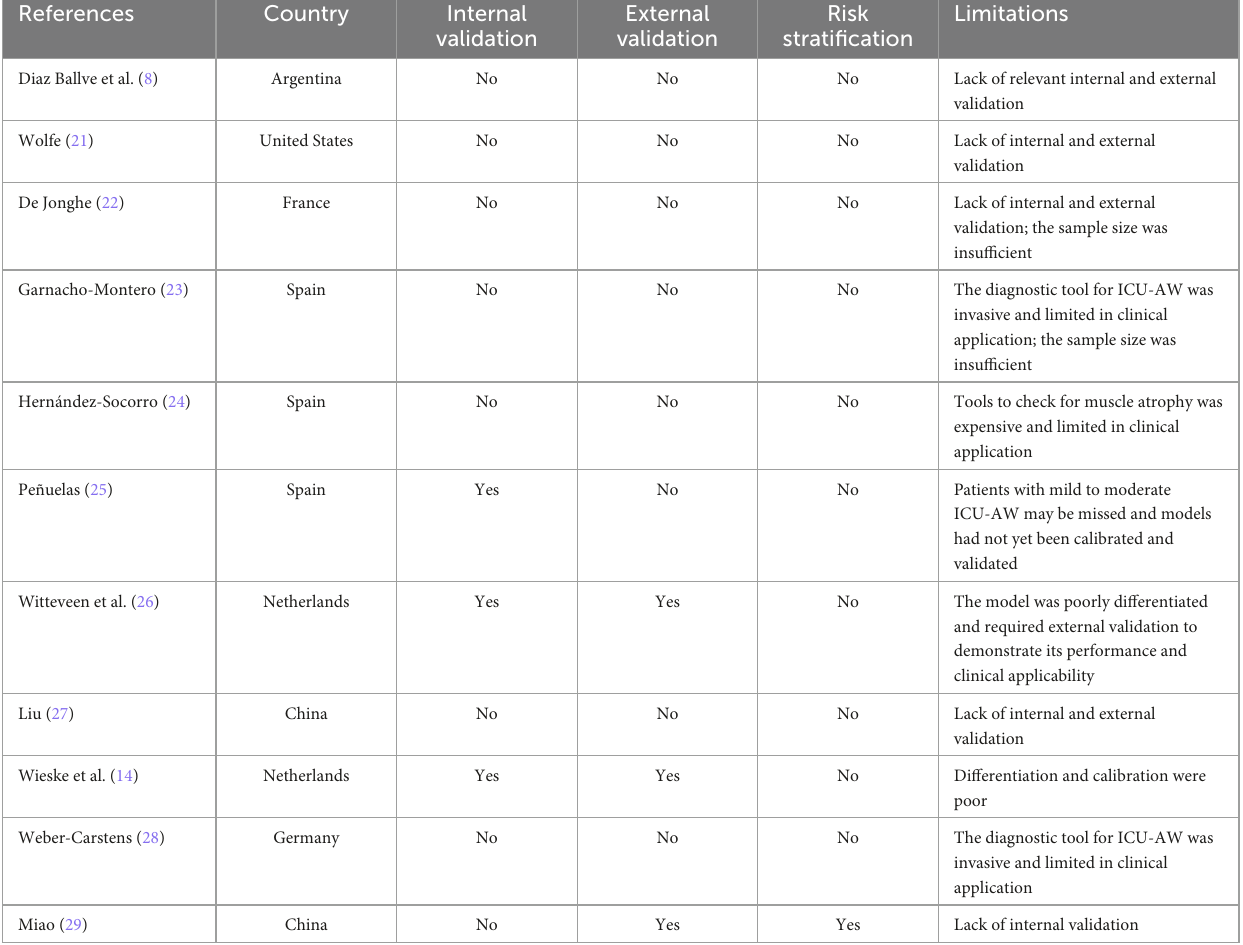
TABLE 1 Summary of previous